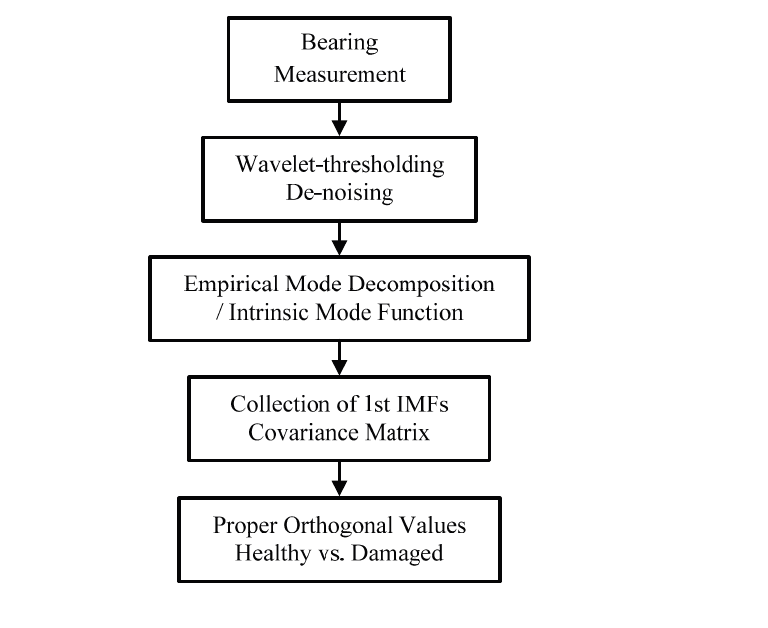
Figure 1. Flow chart of the roller bearing fault monitoring